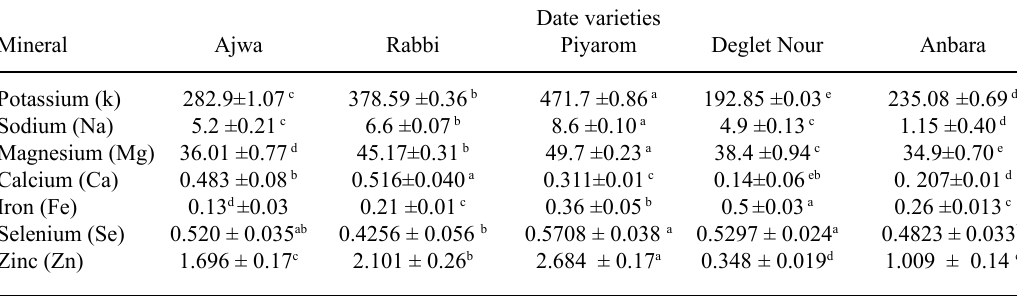
table 3. Mineral content (mg/100g DF) of the selected different varieties of date